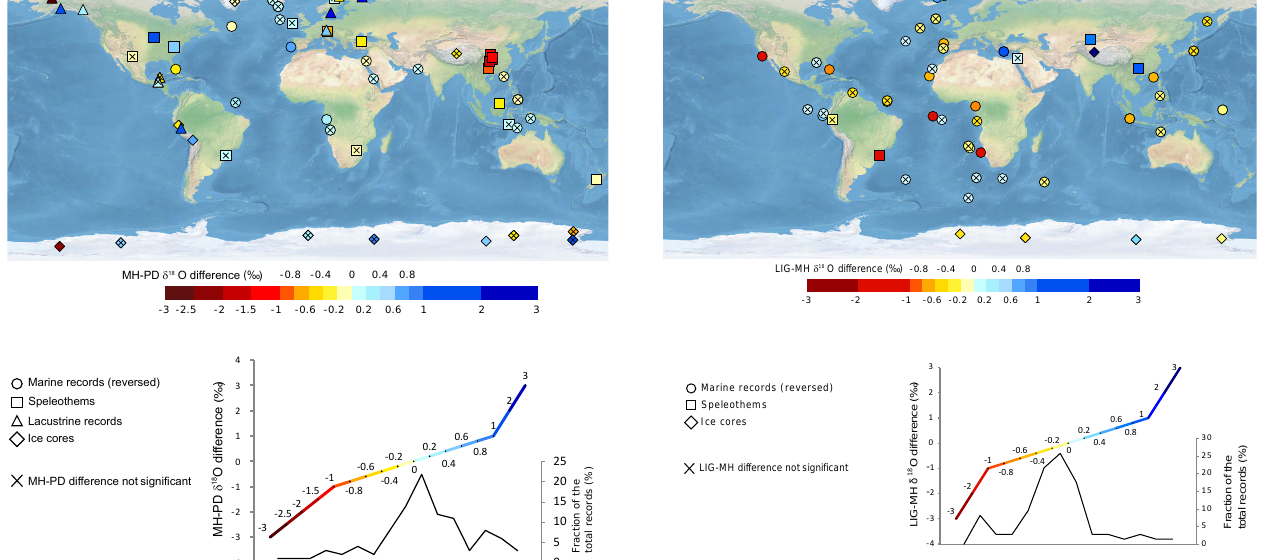
Figure 8. Map showing the location of δ 18 O records spanning the MH and PD with the symbols reflecting the type of source archive and colors documenting the amplitude of δ 18 O variations between these two periods (MH-PD). The bottom figure shows the color scale as well as the fraction of records as a function of the MH-PD δ 18 O anomaly. Note the non-linear scale for δ 18 O difference. The δ 18 O difference from marine records was reversed for coherency with the sign of changes of terrestrial records. Note that some proxi- mate core-sites may not be visible on the figure because of graphical overlaps.